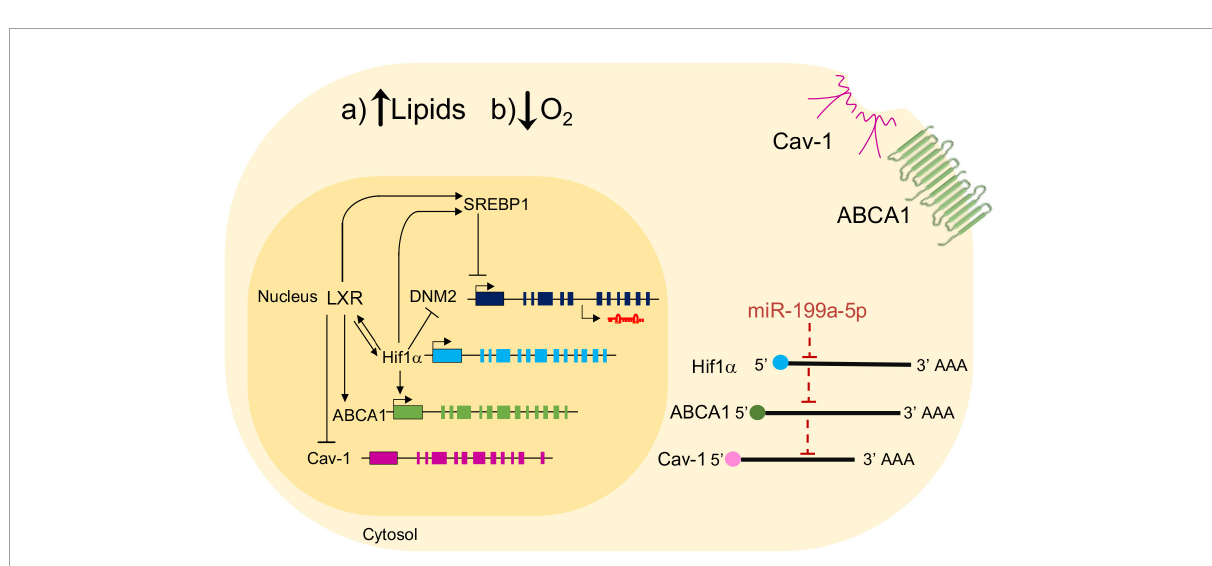
FIGURE9 Schematic showing the effect of miR-199a-5p on ABCA1 and potential interplay mechanisms with key genes involved in atherosclerosis. Schematic overview about a possible regulation of miR-199a-5p in the relation between ABCA1, Cav-1, LXR in hypoxia conditions in mouse peritoneal macrophages. Black arrows represent activation processes and inhibition processes. LXR activates several genes involve in atherosclerosis such as ABCA1, SREBP1 and HIF1 α , but inhibits Cav-1. On the other hand, some of these genes are inhibited by miR-199a-5p and present a possible direct binding for this miRNA on its predicted site in the